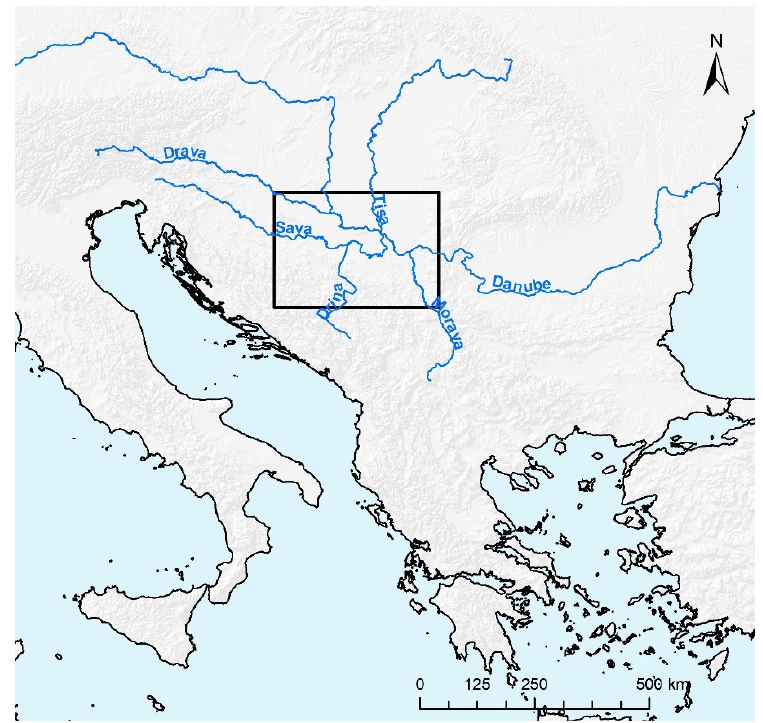
Figure 1. Position of the studied area (rectangle) within SE Europe. Deciduous forests dominated by Hungarian oak ( Quercus frainetto ) appear in the area [30]. In the west, the area of research corresponds to the western localities of Hungar- ian oak in Slavonia (Kutjevo) [31]. In the north, the area includes a major part of Vojvodina. This area is still influenced by the Mediterranean climate, which arrives from the south (Figure 1) along rivers (e.g., Morava) [32]. The southern boundary corresponds to the geomorphological border of the Pannonian Plain [33], which corresponds to the phytogeo- graphic border of the Pannonian Plain toward the Illyrian region proposed [34] and the border of the central European region toward the Mediterranean region